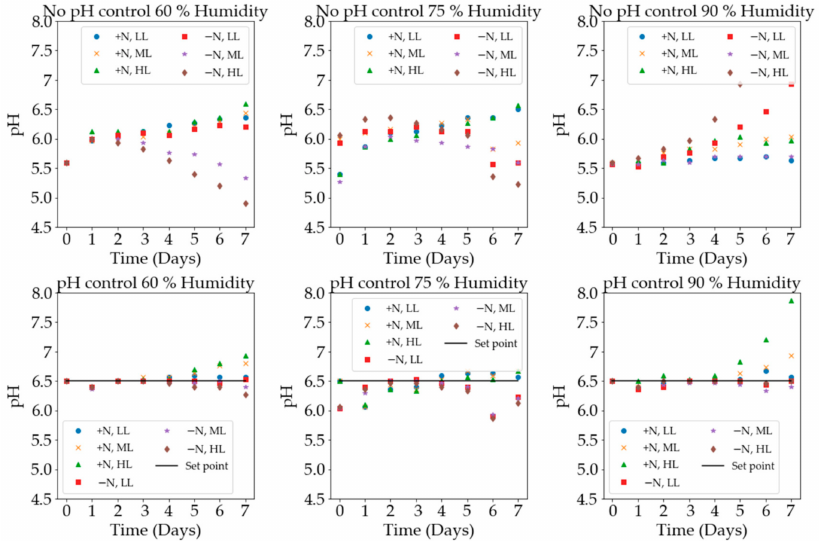
Figure 5. The pH data were measured every day before acid/base dosing. The different light intensities (LL: 5000 lx, ML: 10,000 lx, and HL: 20,000 lx) and the nitrogen presence (+N) or